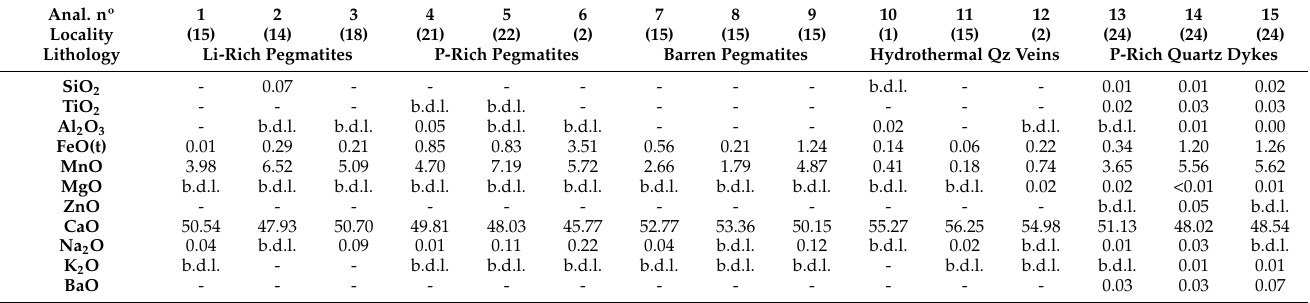
Table 3. Representative microprobe analyses with major element composition (wt.%) and unit formula (a.p.f.u.) calculated on the basis of 26 (O,F,Cl,OH), H 2 O* estimated, for apatite associated with the different pegmatitic types and hydrothermal quartz veins from the CIZ. Locality number as in Figure 1 and Table 1. b.d.l. below the detection limit.—not